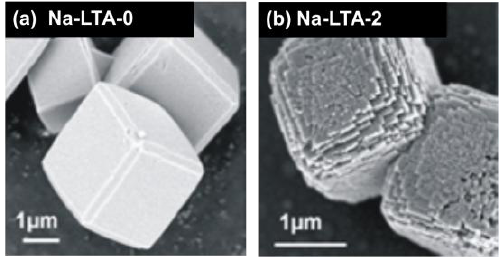
Figure 2. SEM images of crystals of ( a ) the purely microporous zeolite; and ( b ) the mesoporous specimen. The images were taken from the external surface of calcined samples